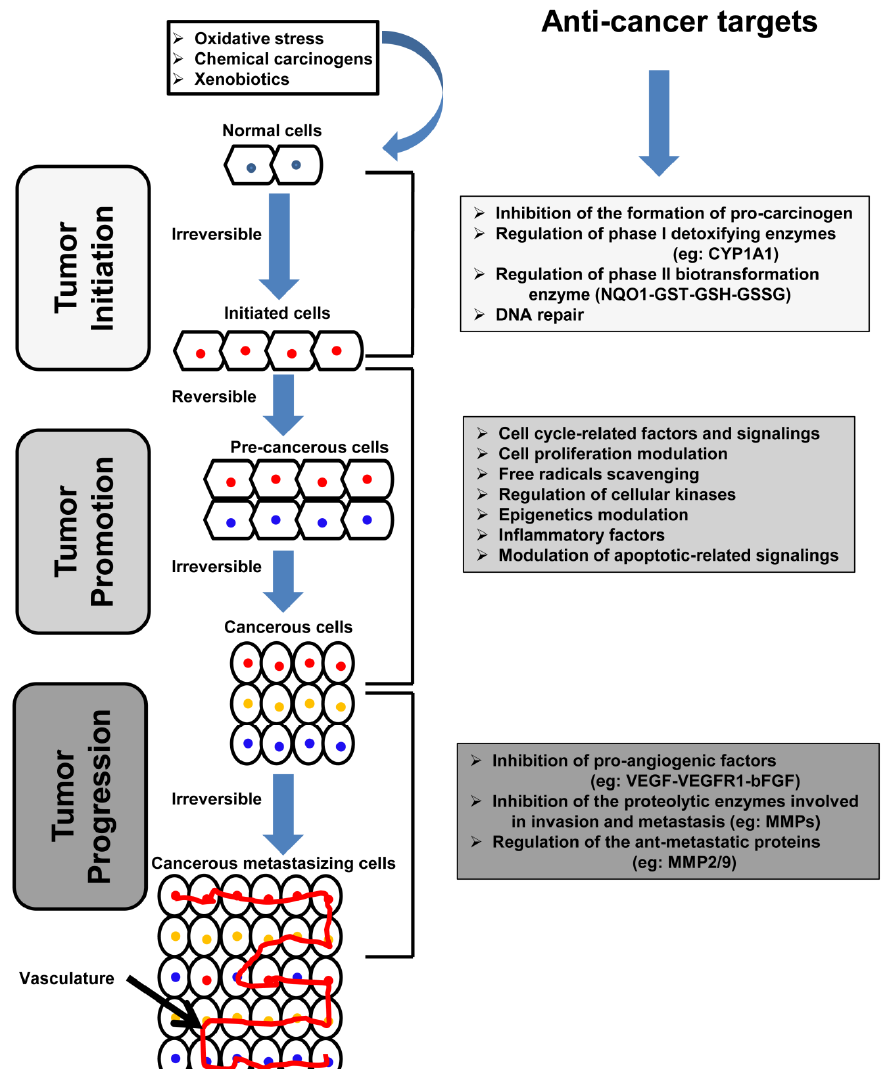
Figure 1. Schematic representation depicting the multistage process, including initiation, promotion, and progression, of carcinogenesis, and the biological targets of polyphenols at each step.